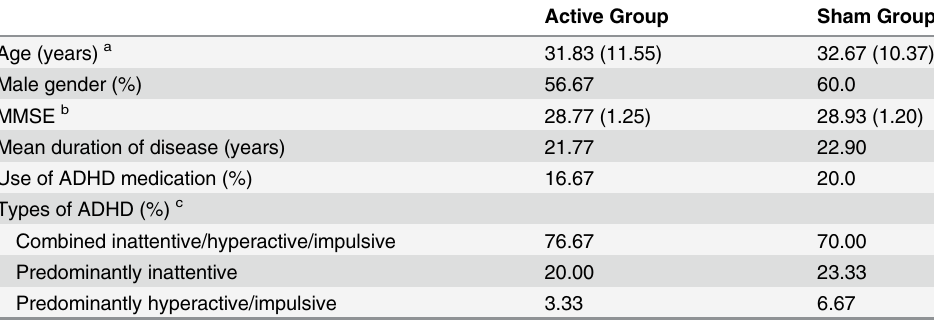
Table 1. Demographic and clinical characteristics at baseline.